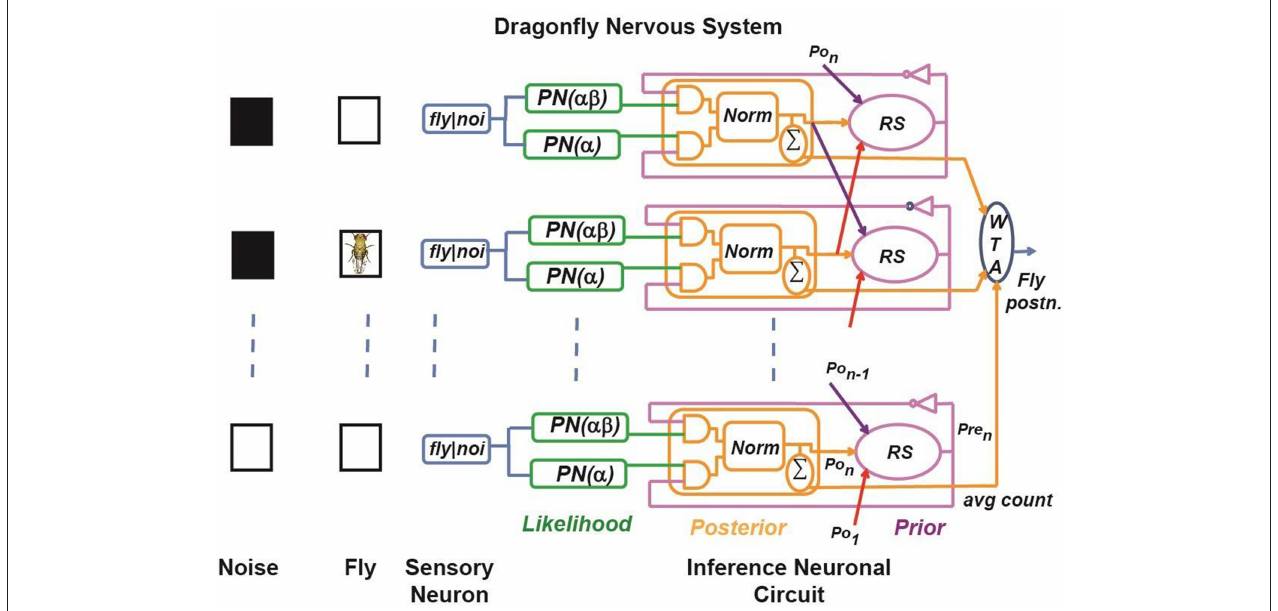
FIGURE 2 | Simplified model of target tracking in a cluttered environment. A dragon fly tracks a fruit fly moving against a randomly flickering background. The sensory afferent neurons of the dragonfly fire probabilistically if there is a fruit fly in the foreground, or a false target ( black box ) in the background of their receptive field. Sensory neurons are implemented using a Poisson spike generation block (PN block). The inference neuron population computes the posterior probability distribution by multiplying the sensory neuron output and the prior probability using a coincidence detector (implemented using an AND gate) and by normalizing the product using a normalization circuit, which is shown as Norm . The prior probability of each state is calculated by sampling from the adjacent neuronal population posteriors according to the transition probabilities. This is shown as the RS (resampling) block. The WTA block represents a winner-take-all circuit, which determines the maximum of the posterior distribution across positions to estimate the fly